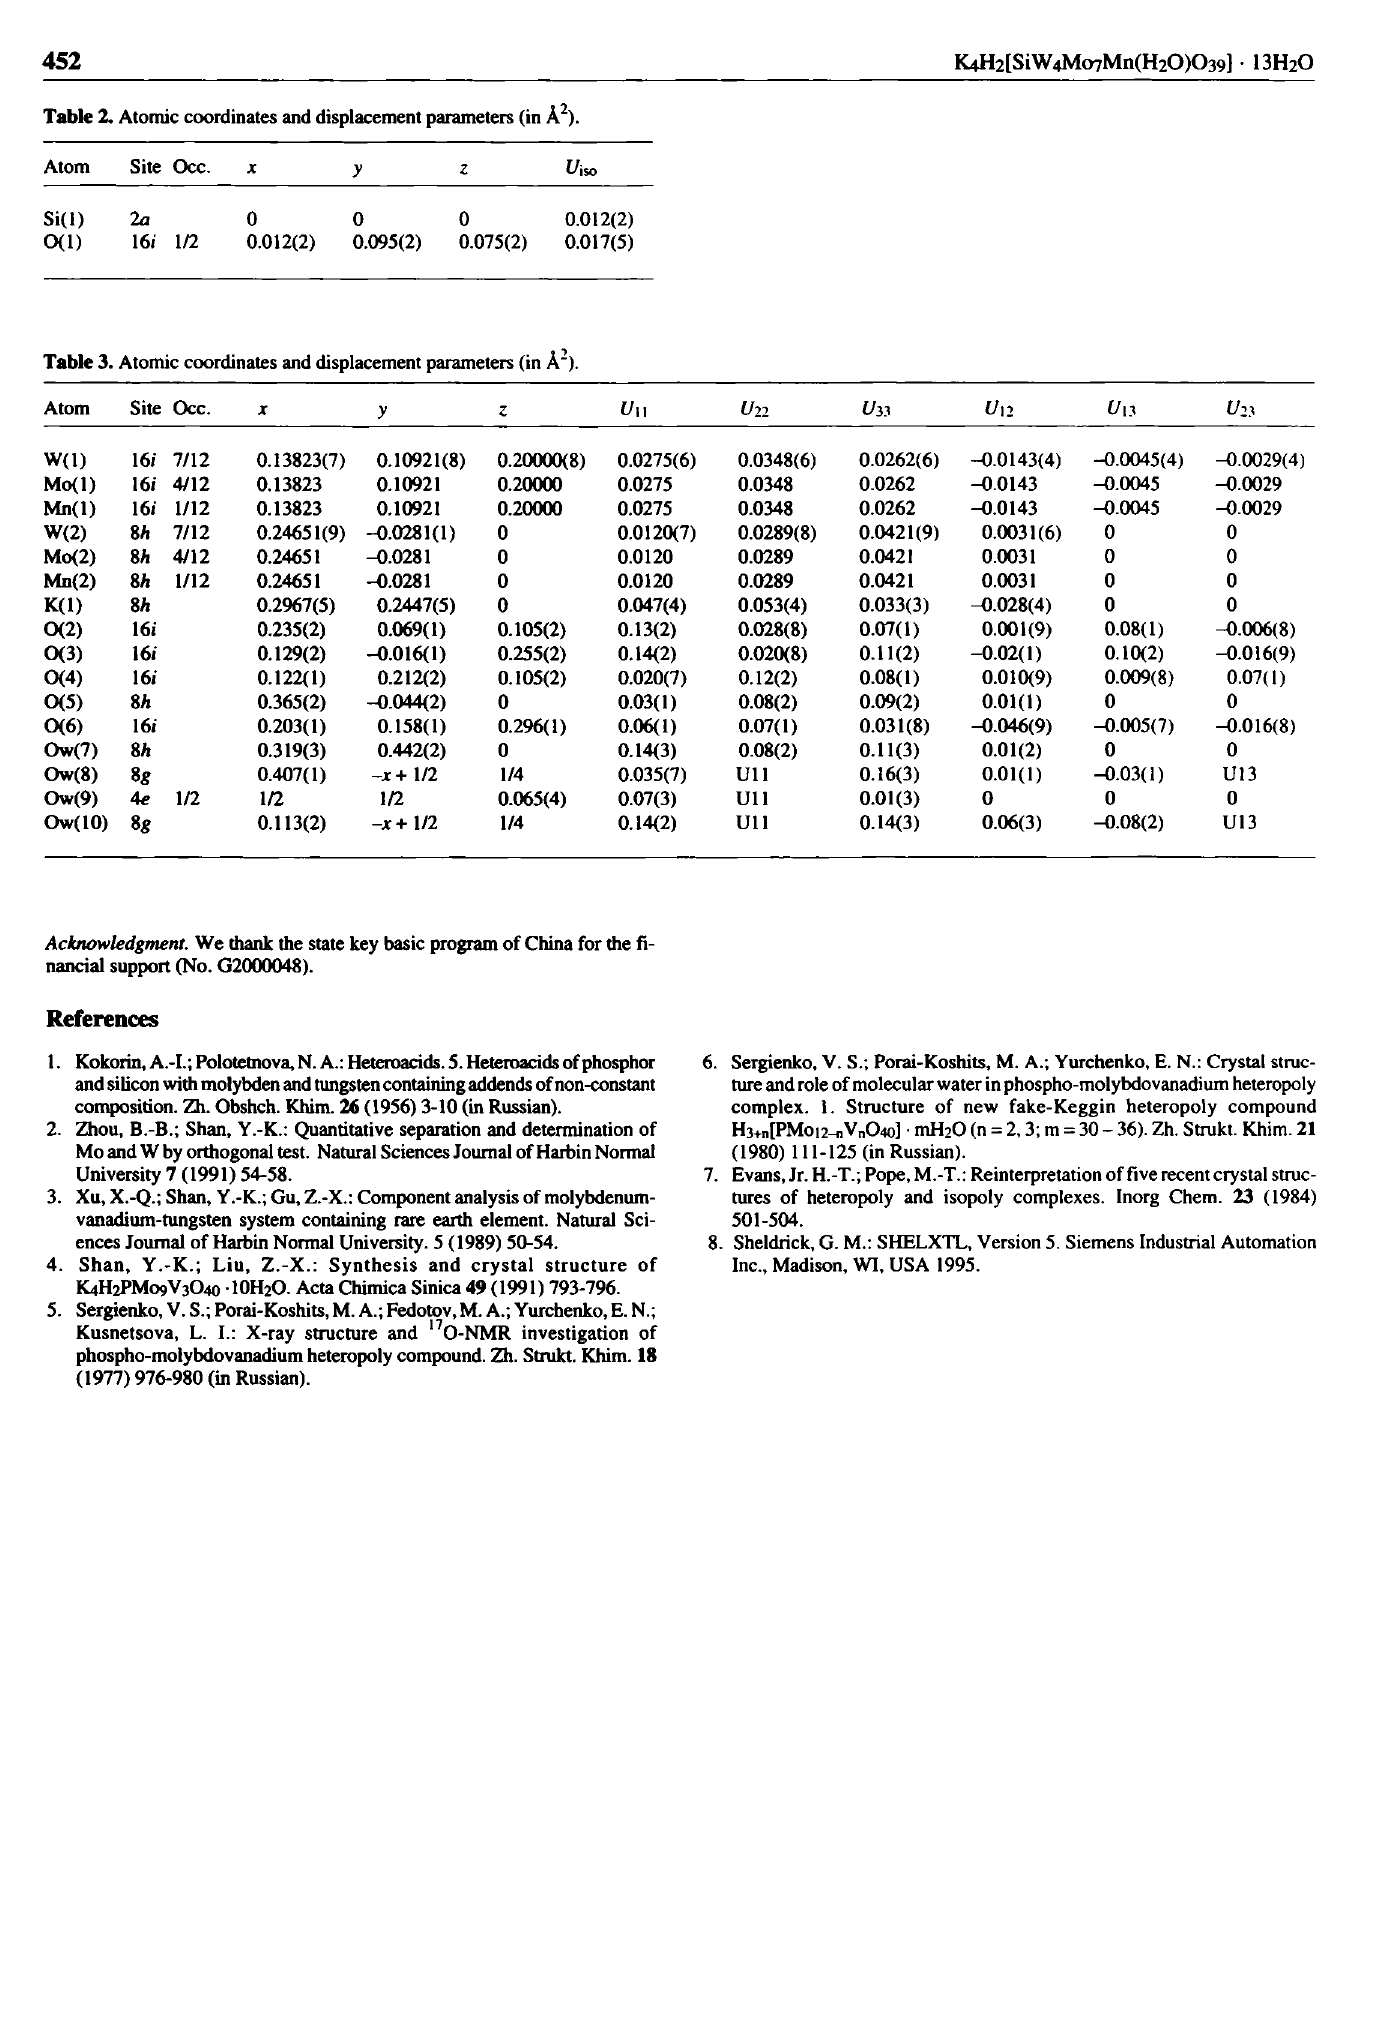
Table 3. Atomic coordinates and displacement parameters (in Â 2